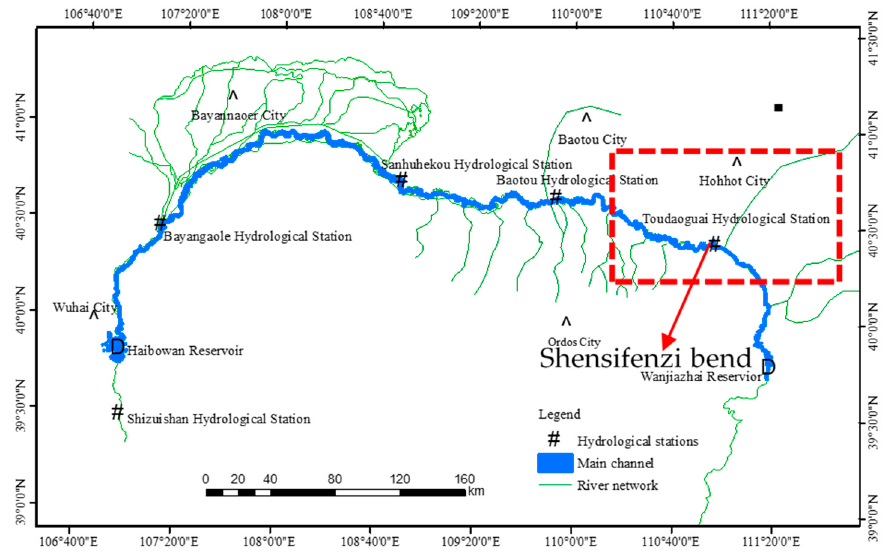
Figure 1. The Inner Mongolia reach of the Yellow River and the Shensifenzi bend location.